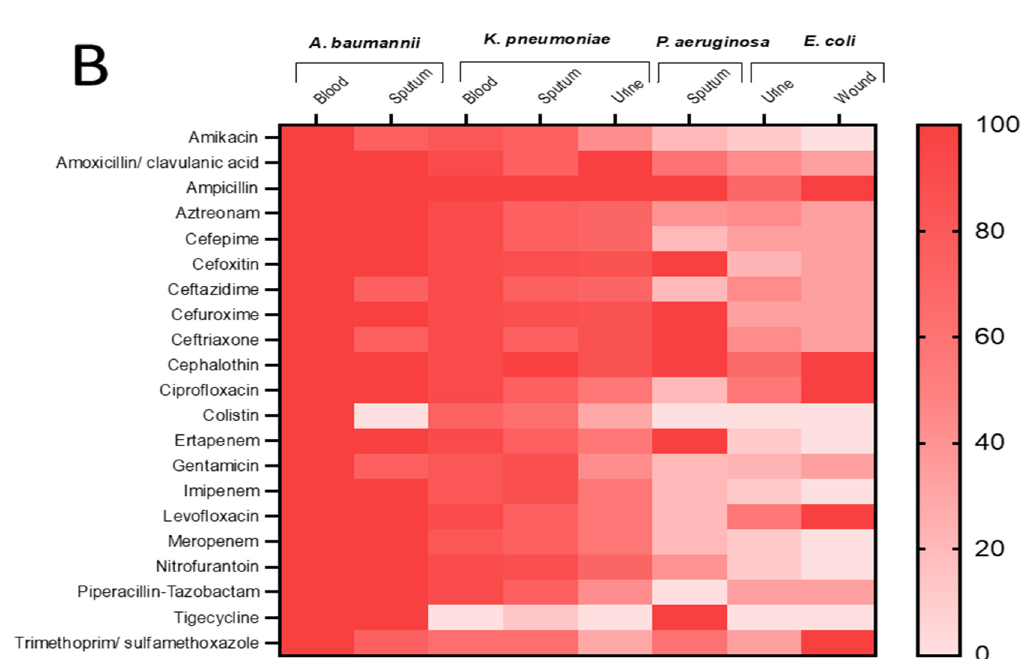
Figure 3. Heat maps representing the percentages of antibiotic resistant bacteria in positive cultures isolated from samples collected from COVID-19 patients in ( A ) ICU and ( B ) non-ICU care.